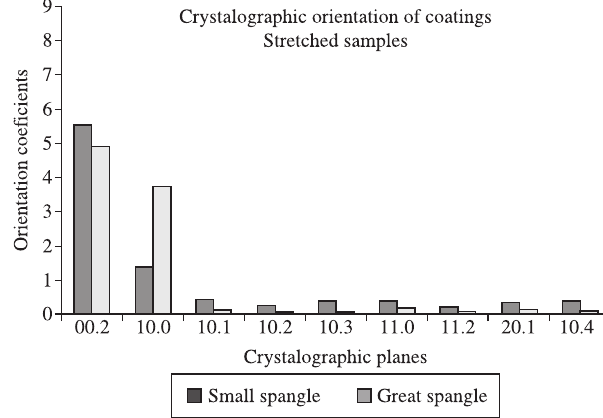
Figure 1. Orientation coefficients of galvanized samples.